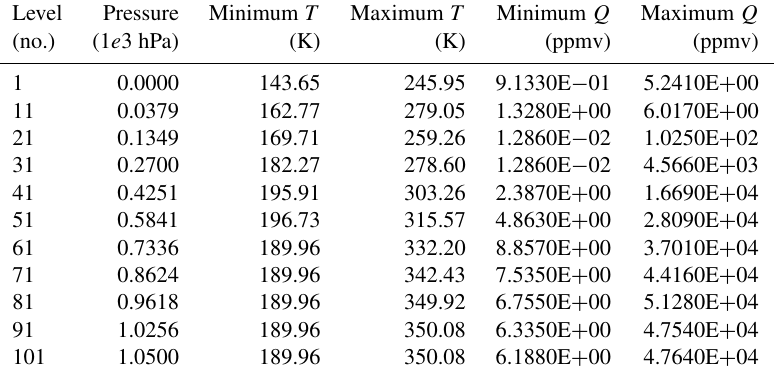
Table 1. A selection of the 101 pressure levels adopted for RTTOV-gb (De Angelis et al., 2016). The table also reports the limits for tem- perature ( T ) and specific humidity ( Q ) at each level representing the range of values used when training the regression coefficients. Note that Q is in part per million in volume over dry air. The full matrix is provided as a Supplement to this paper and freely available online (http://cetemps.aquila.infn.it/mwrnet/main_files/DAT/RTTOVgb_101_pressure_levels_and_regression_limits.xlsx, last access: 14 Novem- ber 2018).